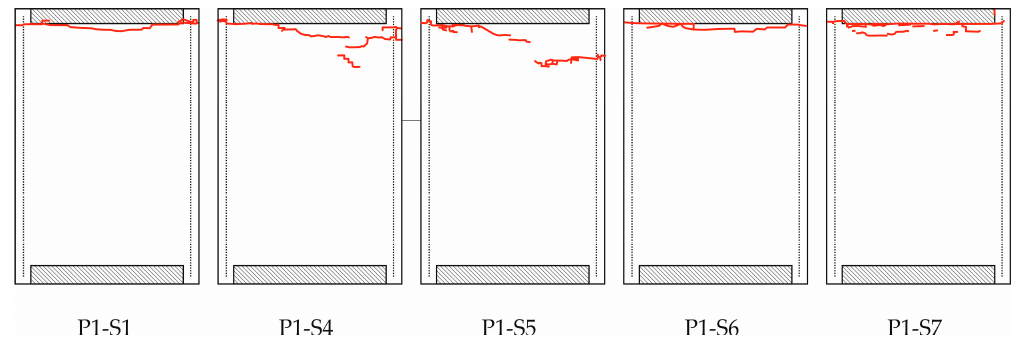
Figure 3. Observable fractures on the surface of the specimen front side tested with CAI-standard indicated by red lines (boundary conditions are described in Figure 1a) for the specimens P1-S1, P1-S4, P1-S5, P1-S6 and P1-S7.